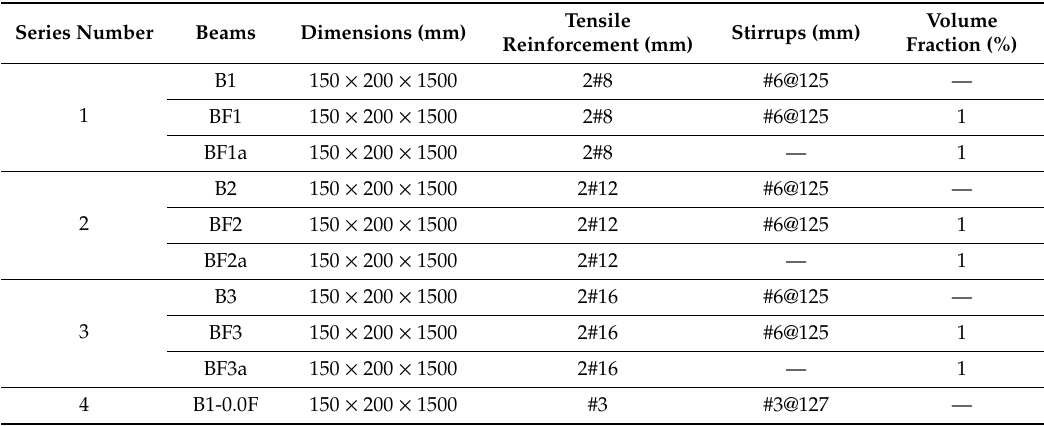
Table 6. Characteristics of the various